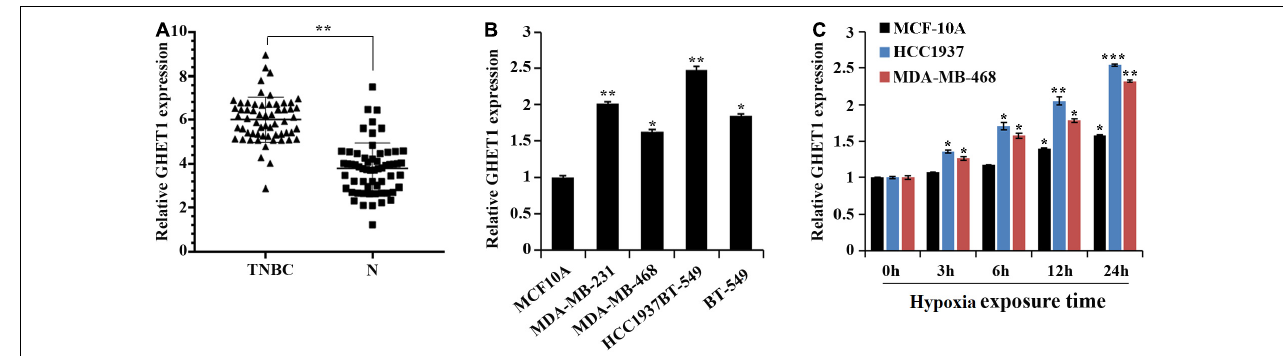
FIGURE 1 | lncRNA GHET1 is upregulated in TNBC and hypoxia promotes the expression of lncRNA GHET1. (A) The expression of lncRNA GHET1 in TNBC and adjacent normal tissues was examined by qRT-PCR. ** P < 0.01. (B) The expression of lncRNA GHET1 was measured in human normal breast epithelial cell MCF10A and TNBC cell lines MDA-MB-231, MDA-MB-468, HCC1937, and BT-549 using qRT-PCR. * P < 0.05 and ** P < 0.01 vs. MCF10A. (C) MCF10A, MDA-MB-468, and HCC1937 cells were cultured under hypoxia conditions for 3, 6, 12, and 24 h. The expression of lncRNA GHET1 was analyzed by qRT-PCR. * P < 0.05 and ** P < 0.01 vs. 0 h. TNBC, triple-negative breast cancer.